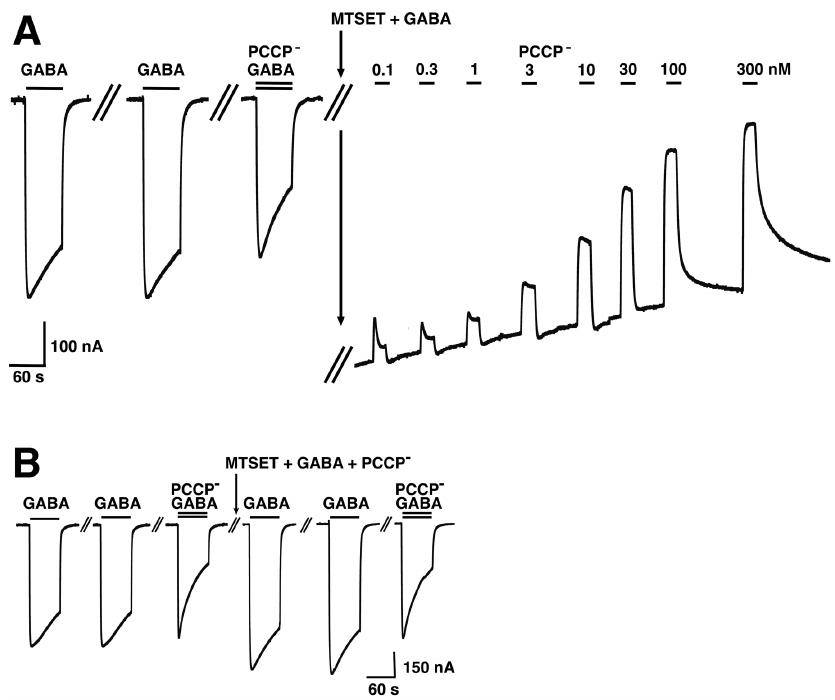
Figure 9. PCCP 2 prevents the increase in PCCP 2 sensitivity of a 1 T260 b 2 c 2 mediated by MTSET + + GABA. GABA (EC 10 ) was applied repetitively until a stable current response was observed followed by inhibition of the channel by PCCP 2 . Subsequently 5 mM MTSET + was applied in the presence of GABA. After MTSET + treatment GABA was applied twice followed by a combined application of GABA and the same concentration of PCCP 2 used before. A, The treatment leads to a spontaneously open channel and an enhanced inhibition in a 1 T260C b 2 c 2 . B, 5 mM MTSET + was applied to a 1 T260C mutant receptor in presence of GABA and 1 mM PCCP 2 . PCCP 2 prevents the open channel formation. These experiments were repeated independently three times using different